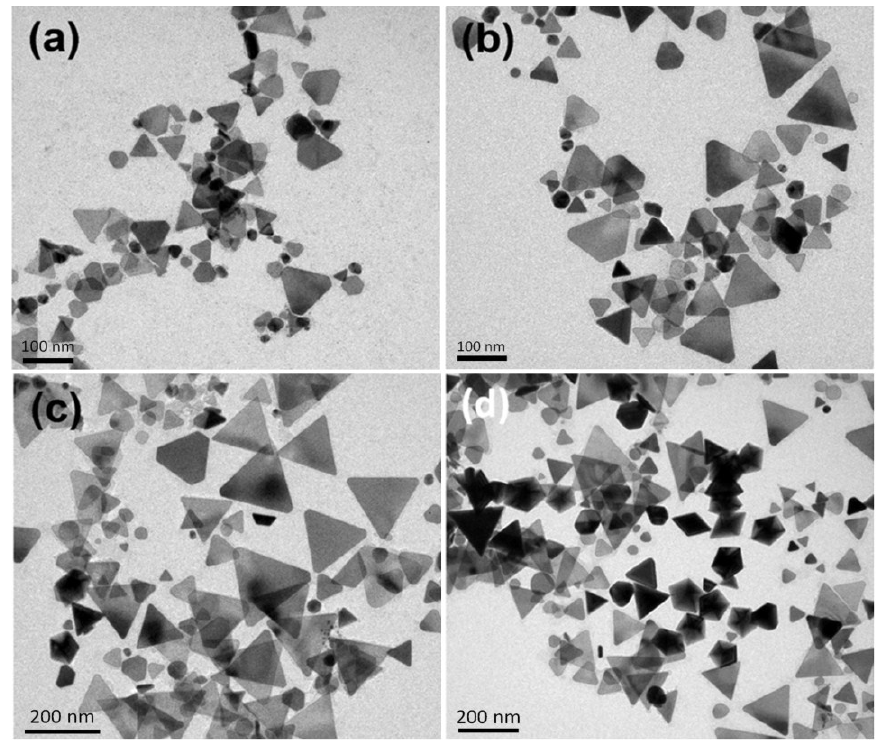
Figure 8. TEM images of the silver nanoparticles synthesized at 20 °C and at different reaction times: ( a ) 4 h; ( b ) 7 h; ( c ) 21 h and ( d ) 25 h.